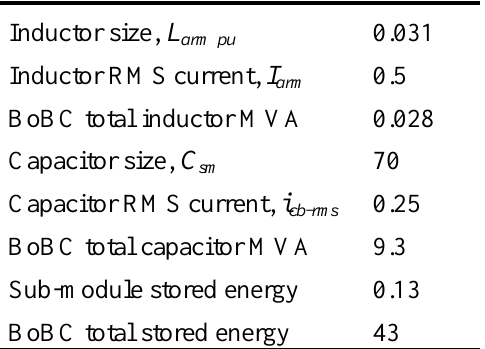
Table 5. Benchmark reactive component summary for BoBC